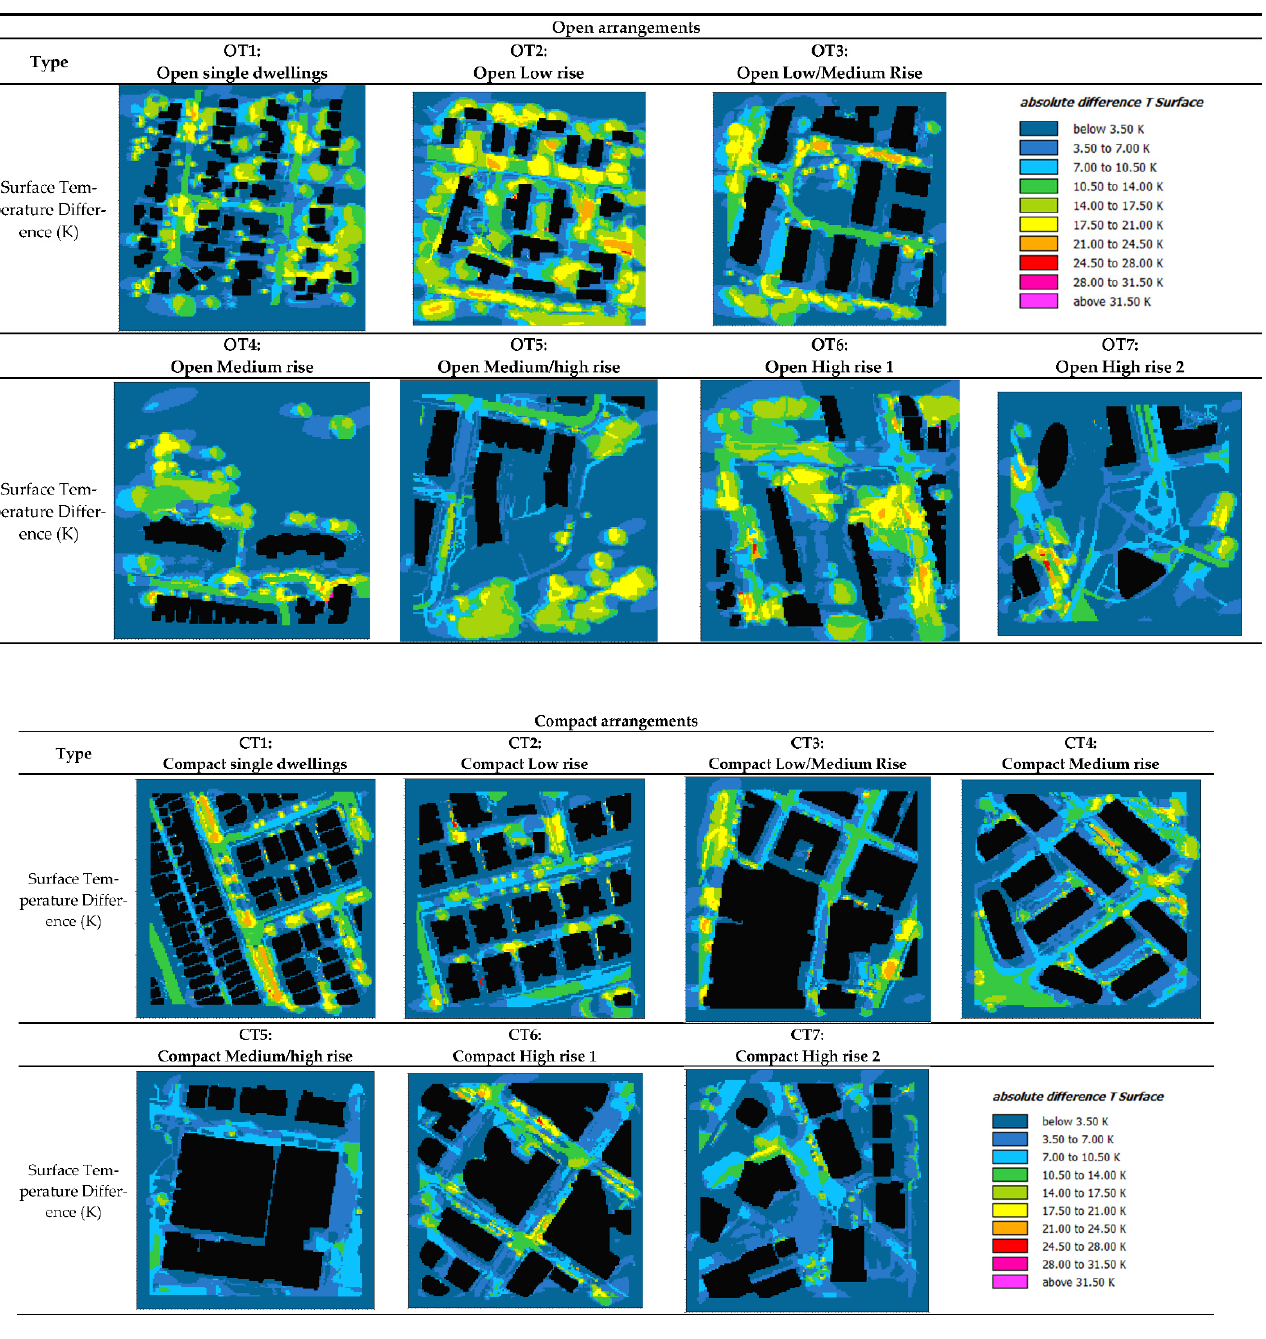
Figure 6. Surface Temperature Comparison Charts for mitigated vs unmitigated cases and 14:00.